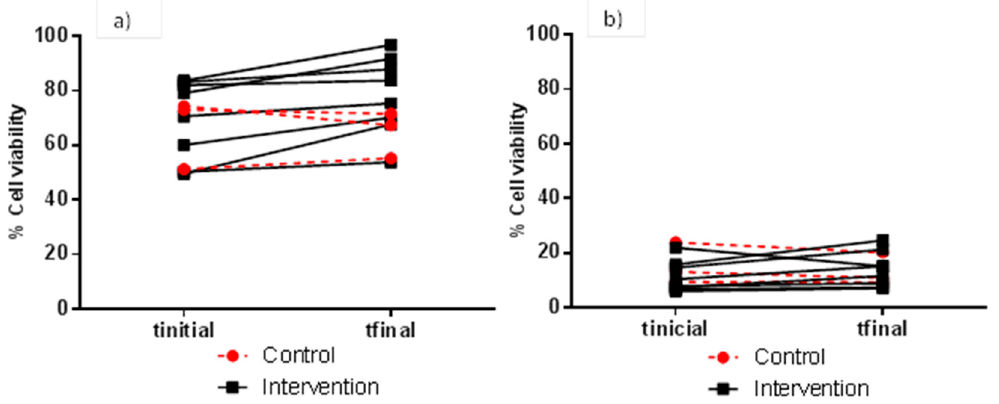
Figure 2. Individual evolution of viability (% with respect to the control) of HT-29 cells after exposure to FW from the control and intervention groups. Cytotoxicity assay conditions: 1:2 ( v / v ) for FW dilution, and 4 h ( a ) and 24 h ( b ) for incubation time.